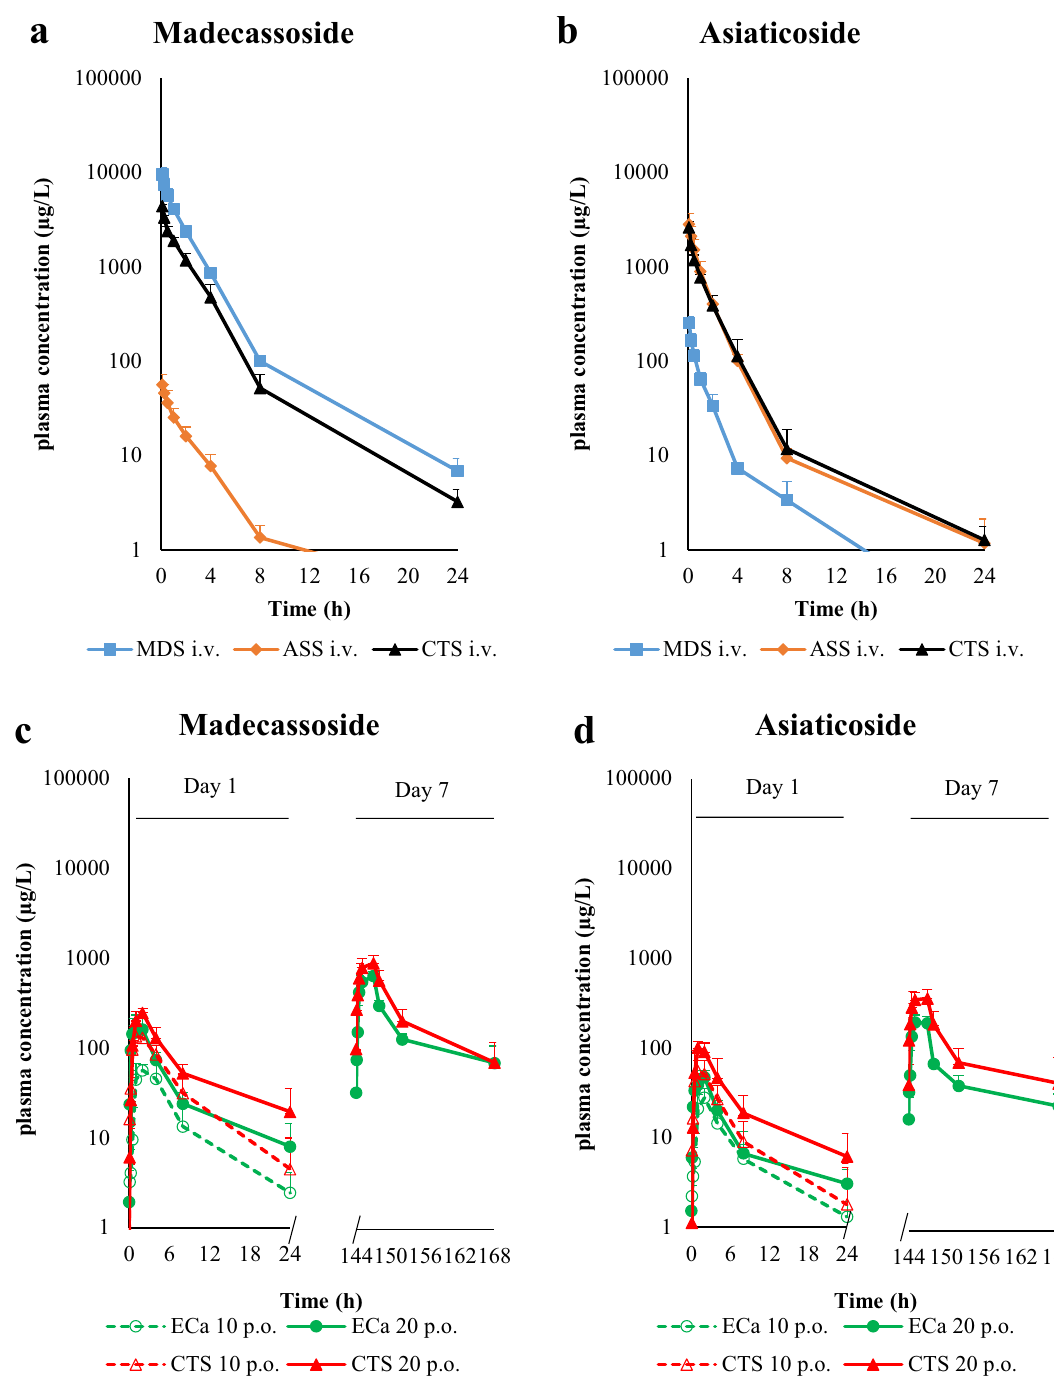
Figure 2. Plasma concentration–time profiles of madecassoside and its conversion from asiaticoside ( a ) and asiaticoside and its conversion from madecassoside ( b ) after intravenous administration of pure compounds and Centell-S, and madecassoside ( c ) and asiaticoside ( d ) after oral administration of ECa 233 and Centell-S. Data are presented as the mean ± standard deviation (n =